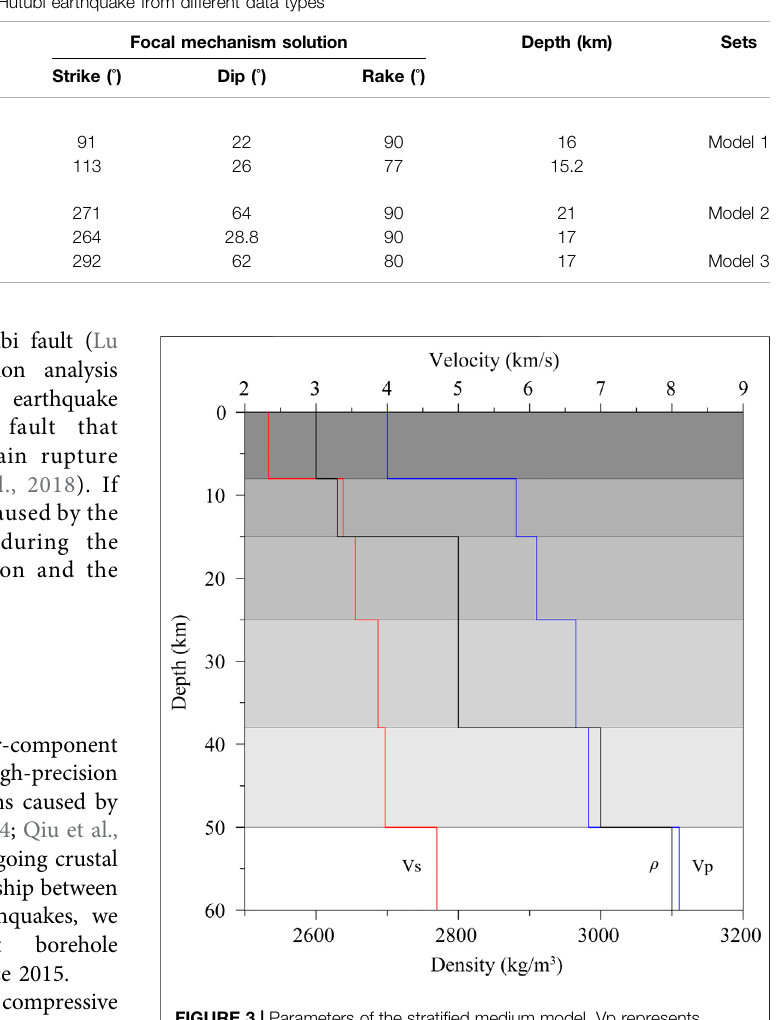
FIGURE 3 | Parameters of the strati fi ed medium model. Vp represents the P-wave seismic velocity, Vs represents the S-wave velocity, ρ represents the lithospheric